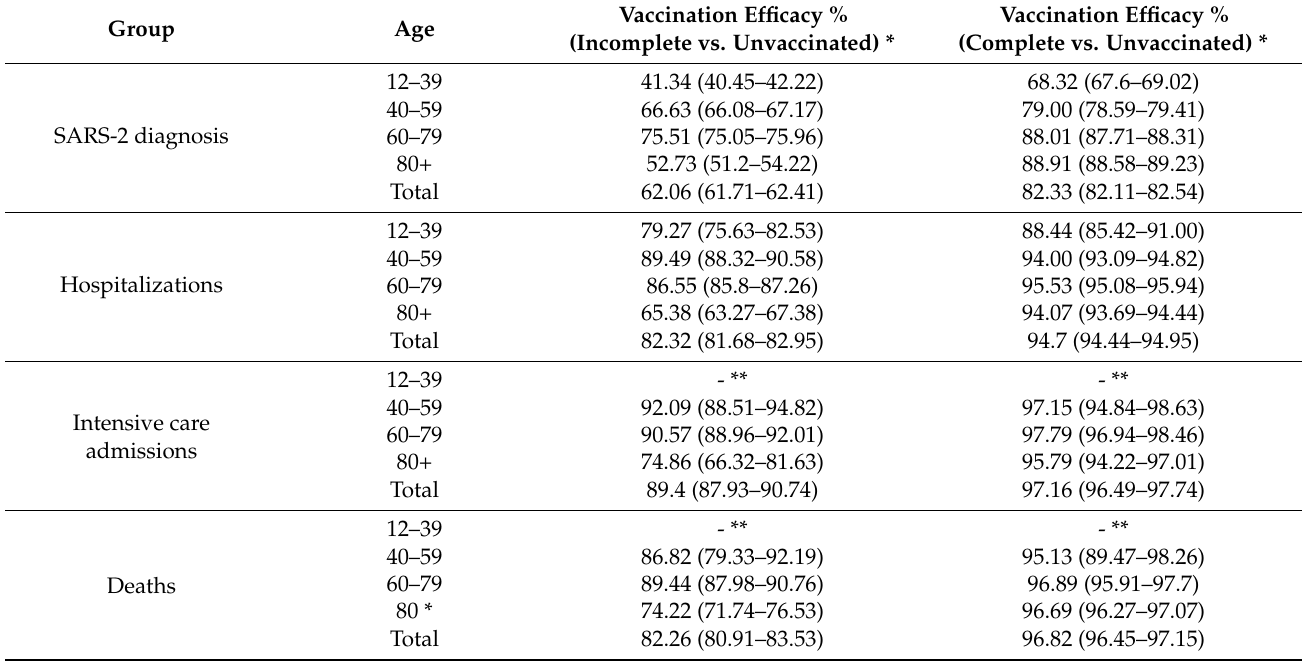
Table 4. Estimated vaccination efficacy in the Italian population aged >12 years in cases of COVID-19 cases diagnosed in the period 4 April–8 August 2021, with 95% confidence interval (Produced by the Istituto Superiore di Sanit à (ISS), Rome. Data updated to 11 August